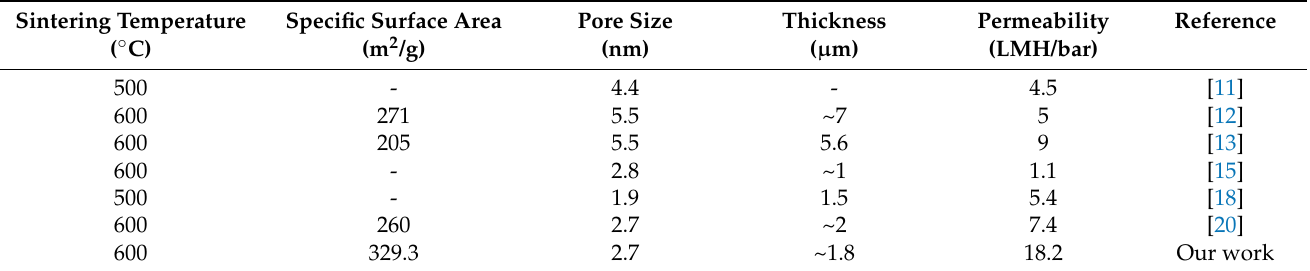
Table 1. Comparison of the characteristics of γ -Al 2 O 3 membranes from references. Sintering Temperature Specific Surface